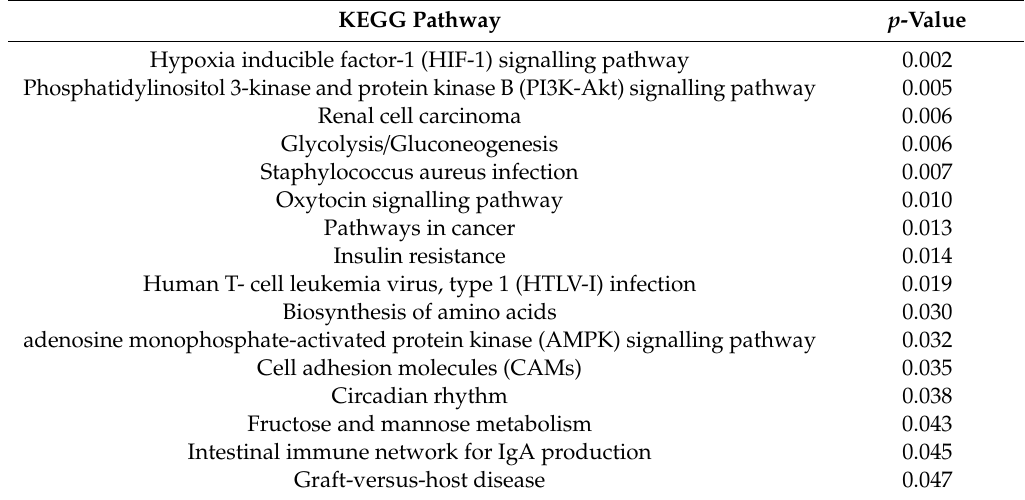
Table 2. Kyoto encyclopedia of genes and genomes (KEGG) pathway analysis of all significantly upregulated genes in response to hypoxia in human